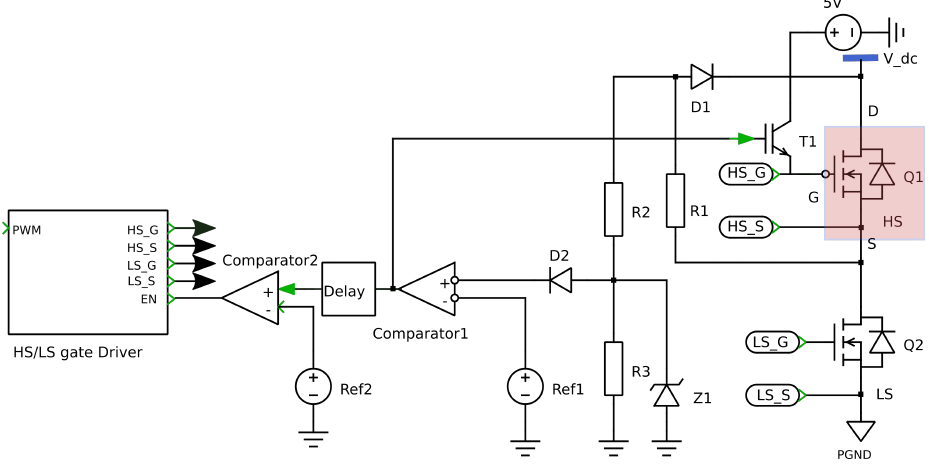
Figure 7. Short-circuit detection and turn-off